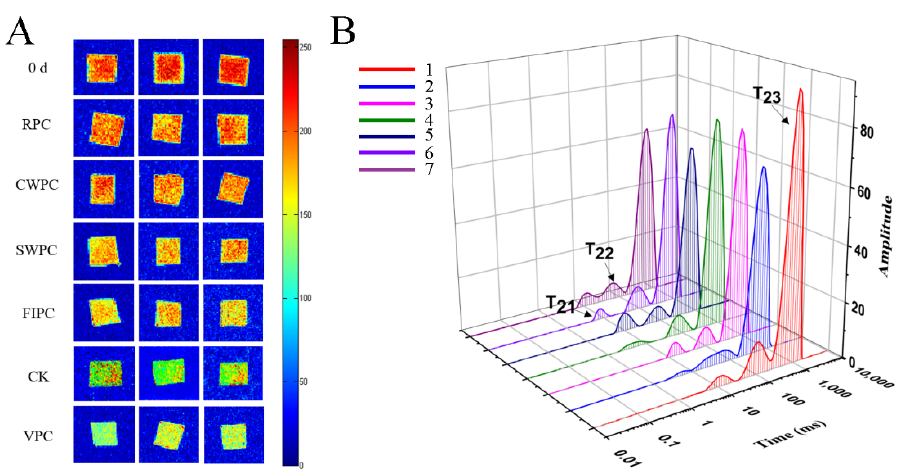
Figure 5. Analysis by LF-NMR: ( A ) plot of magnetic-resonance imaging on day 0 and day 15, where red is the region of high proton density, and blue is the region of low proton density; ( B ) plot of water distribution of yellow-peach samples on day 0 and day 15, where T 21 represents bound water, T 22 represents nonfluid water, and T 23 represents free water; the peak and peak area represent the contents of different kinds of water; 1: Day 0; 2: CK; 3: RPC; 4: CWPC; 5: FIPC; 6: SWPC; 7: VPC. The abbreviations CK, RPC, CWPC, SWPC, FIPC, and VPC in the figure correspond to control group, refrigerator precooling, cold-water precooling, strong-wind precooling, fluidized-ice precooling, and vacuum precooling, respectively.